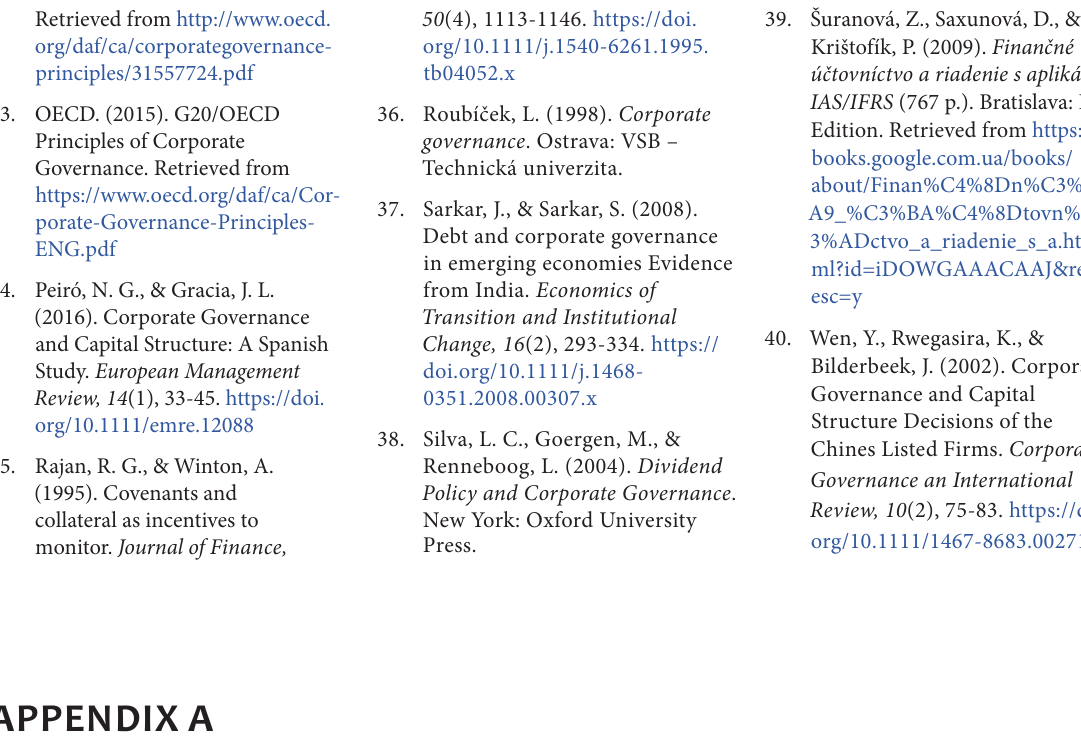
Table A1. Evaluation of 1st, 2nd, 3rd and 4th criteria and